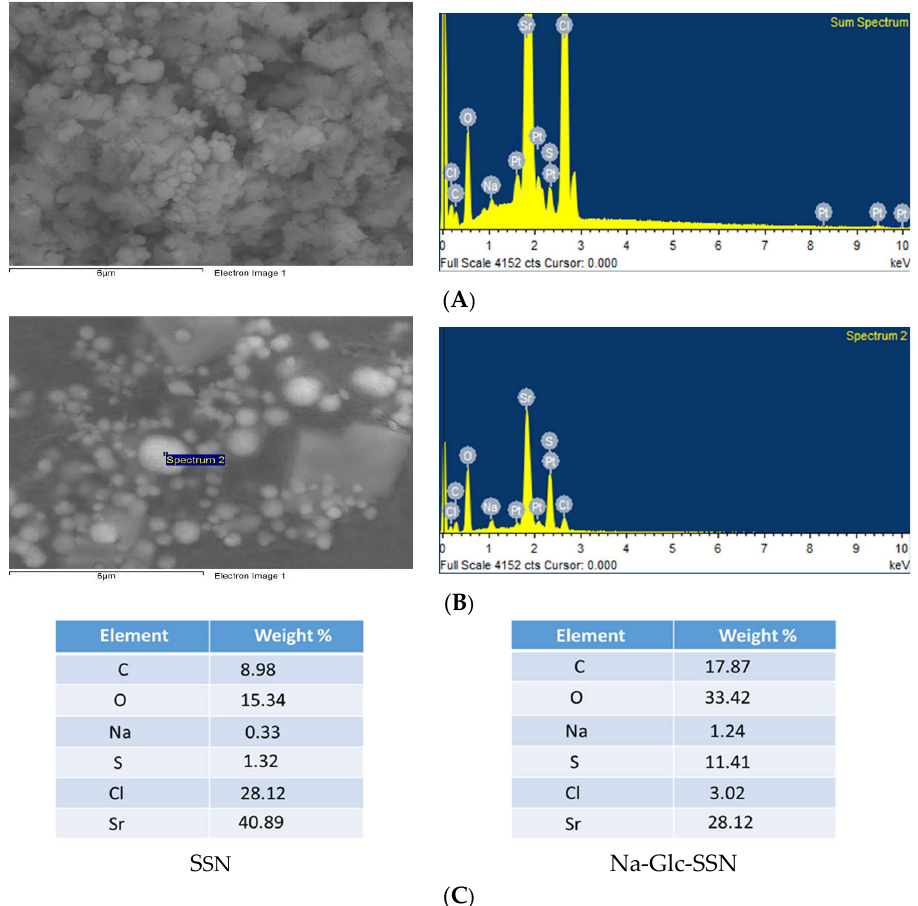
Figure 6. EDX analysis of nanoparticles. EDX spectrum of SSNs ( A ) and Na-Glc-SSNs ( B ) nanoparticle ( C ). Element weight percent of SSNs and Na-Glc-SSNs.